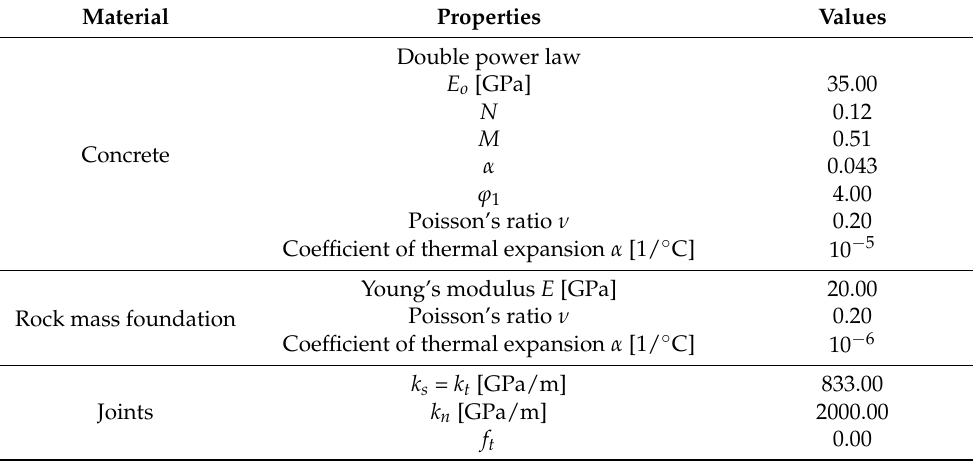
Table 2. Mechanical material